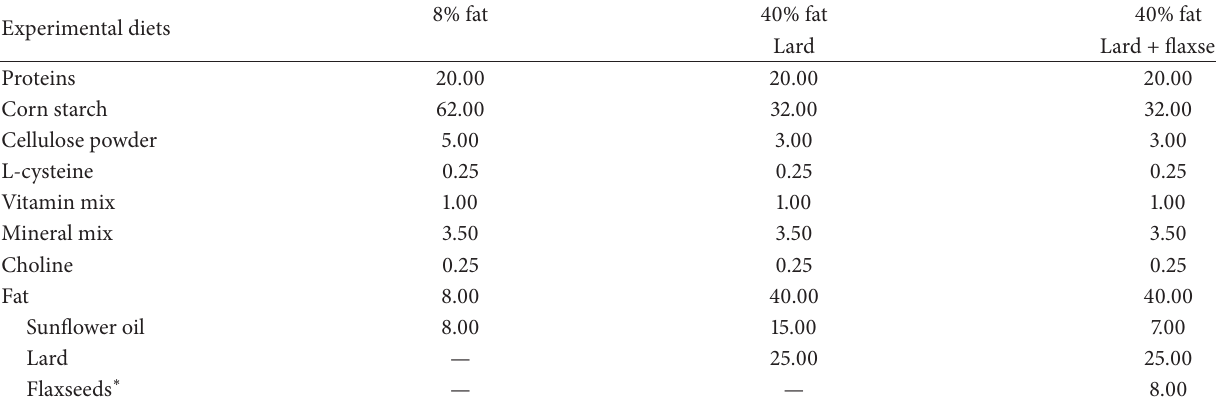
Table 1: Composition of experimental diets (%; w/w).